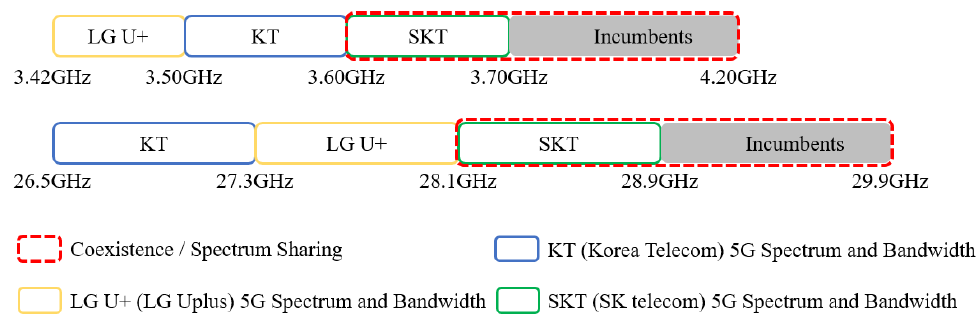
Figure 1. Korea’s 5G frequency allocations and adjacent bands [1].